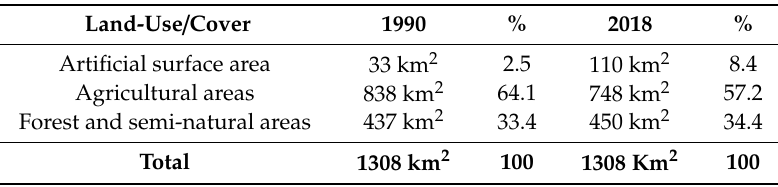
Table 4. Changes between 1990 and